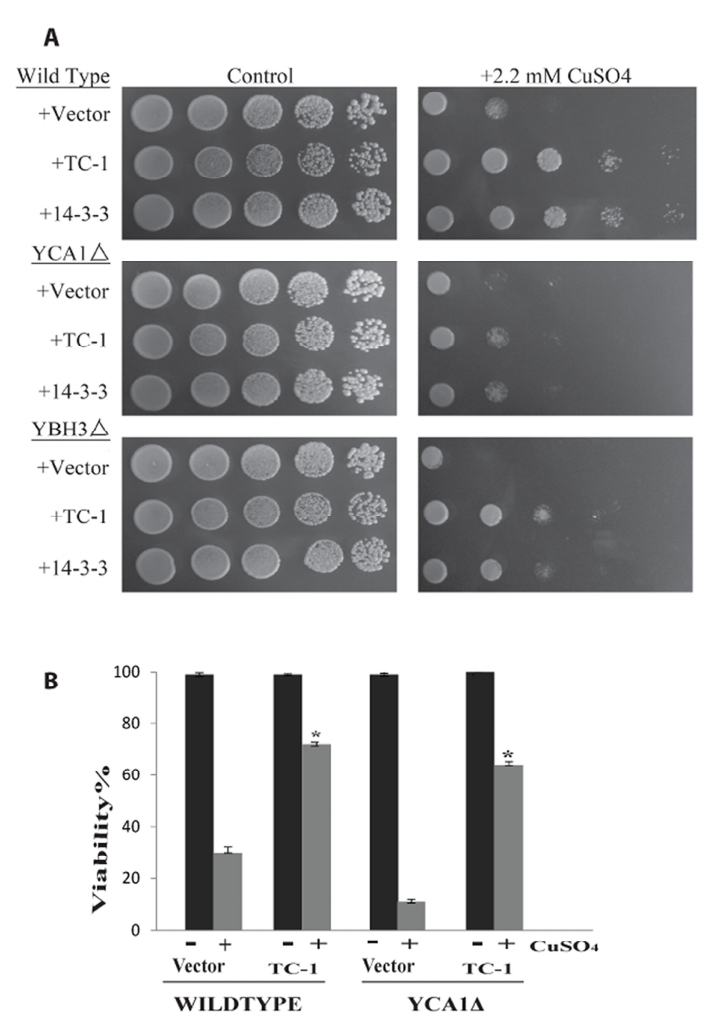
(Figure 3A). In order to examine the possibility that TC-1 may be inhibiting a specific YCA1p and/or YBH3p pathway, we investigated if the knockout of YBH3 or YCA1 would affect the ability of TC-1 to protect the cell. Cultures of wild type as well as YCA1 Δ and YBH3 Δ mutants harbouring the vector, TC-1, or 14-3-3-expressing plasmids, were spotted onto nutrient agar plates with and without copper stress (Figure 4A). TC-1 was able to overcome the inhibitory ef- fects of copper in all three strains.